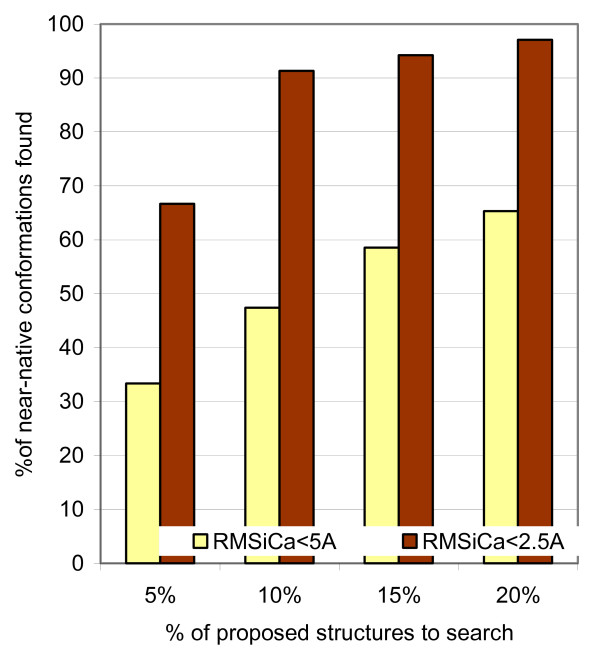
Enrichment of near-native structures on the lower ranks for enzyme-inhibitor complexes. The yellow bars show the enrichment for near-native complexes with RMSiCα<5Å and the brown boxes with RMSiCα<2.5Å (100%: 1956 structures with RMSiCα<5Å and 69 structures with RMSiCα<2.5Å).